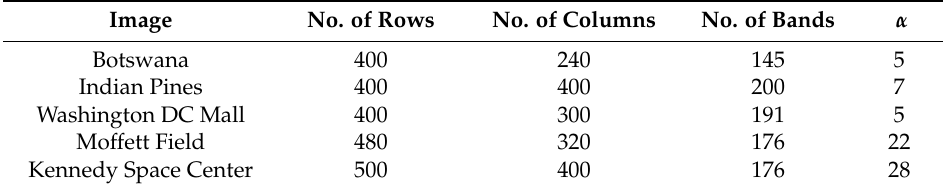
Table 1. The spatial and spectral dimensions of the considered hyperspectral datasets (reference images) and the value of the regularization parameter used in the proposed algorithm with each dataset. Image No. of Rows No. of Columns No. of Bands α Botswana 400 240 145